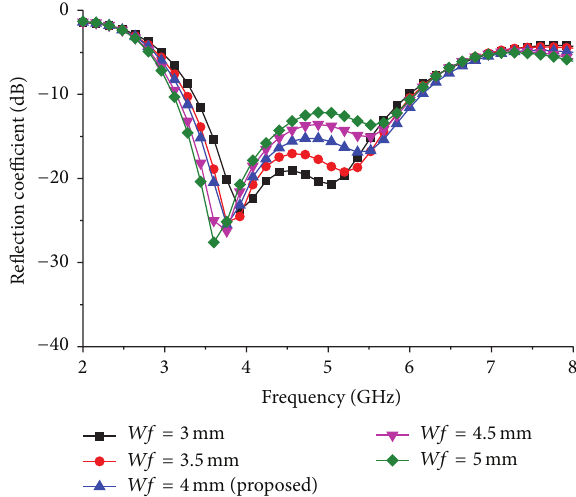
Figure 5: Effect of reflection coefficient for different values of 𝐿1 .